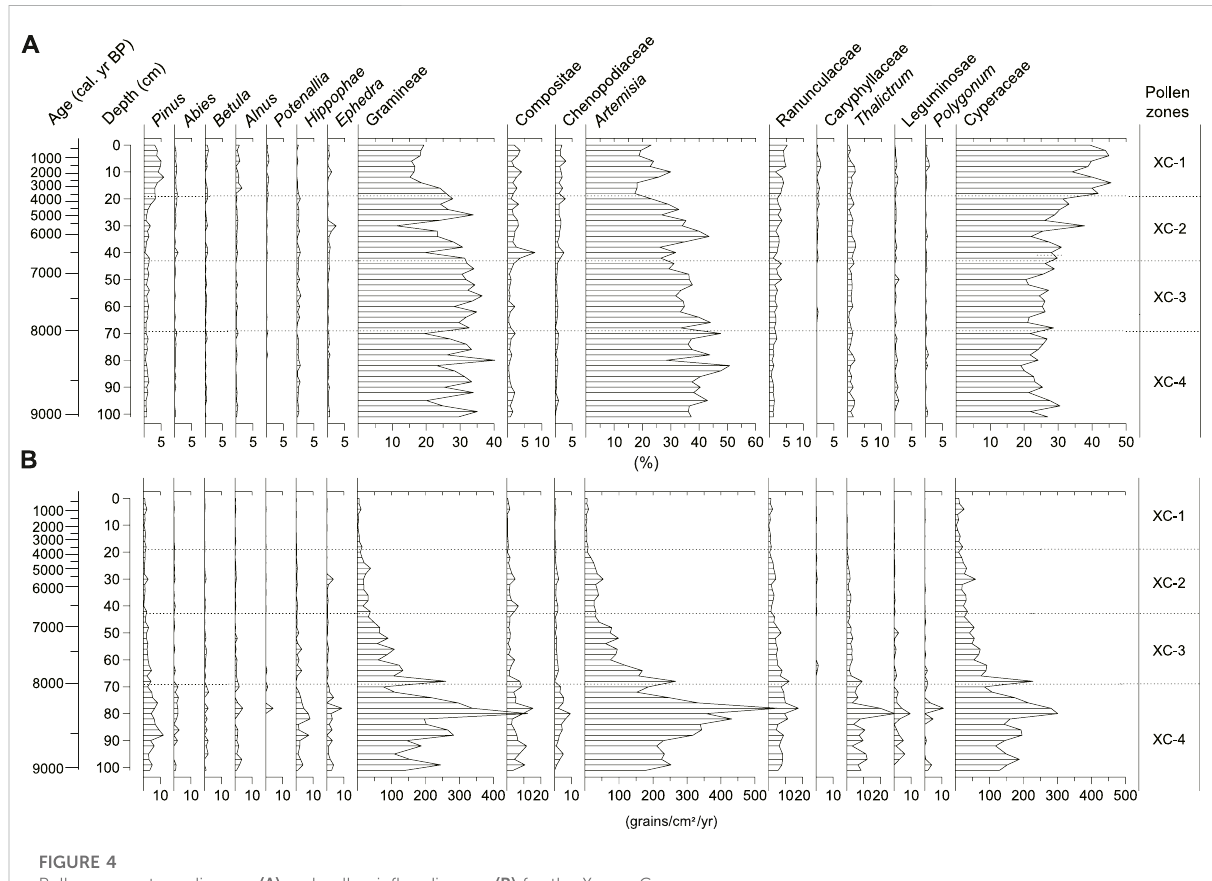
FIGURE 4 Pollen percentage diagram (A) and pollen in fl ux diagram (B) for the Xuguo Co